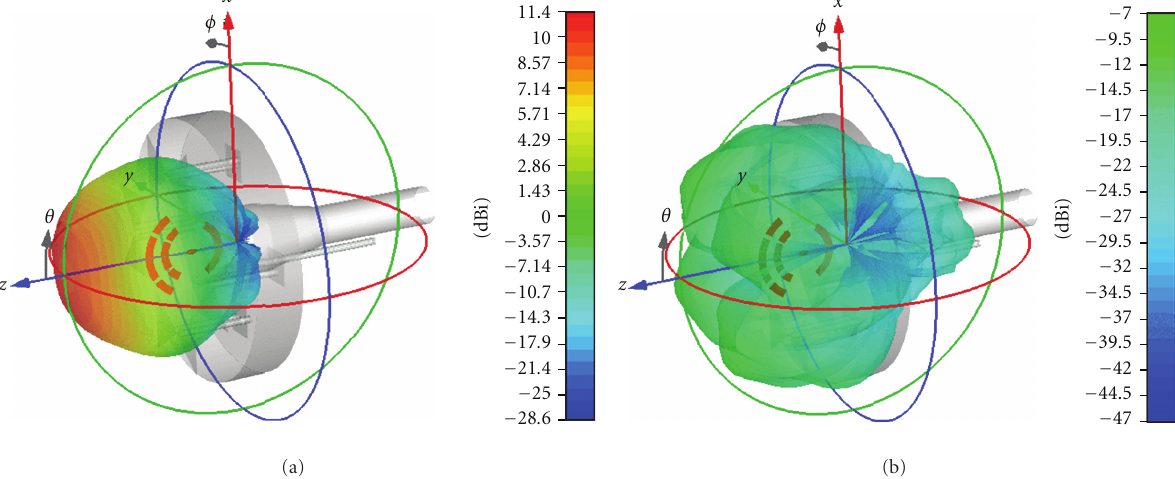
Figure 7: 3D radiation pattern at 2320 MHz; copolarization (a) and cross-polarization (b).